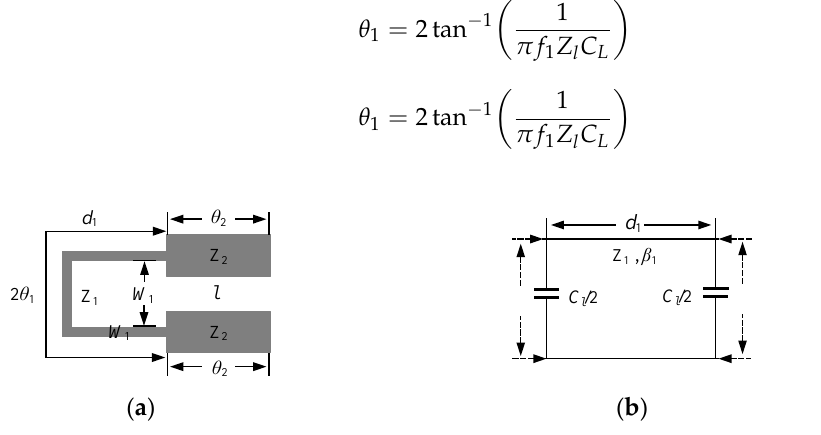
Figure 3. SIR resonator. ( a ) Planar circuit; ( b ) equivalent circuit. The fundamental resonant frequency f 1 and the second spurious resonant frequency f 2 can be determined. Now, it can be seen from Equations (7a) and (7b) that θ 1 = π and θ 2 = 2 π when C l = 0. This is the case for the unloaded half-wavelength resonator.